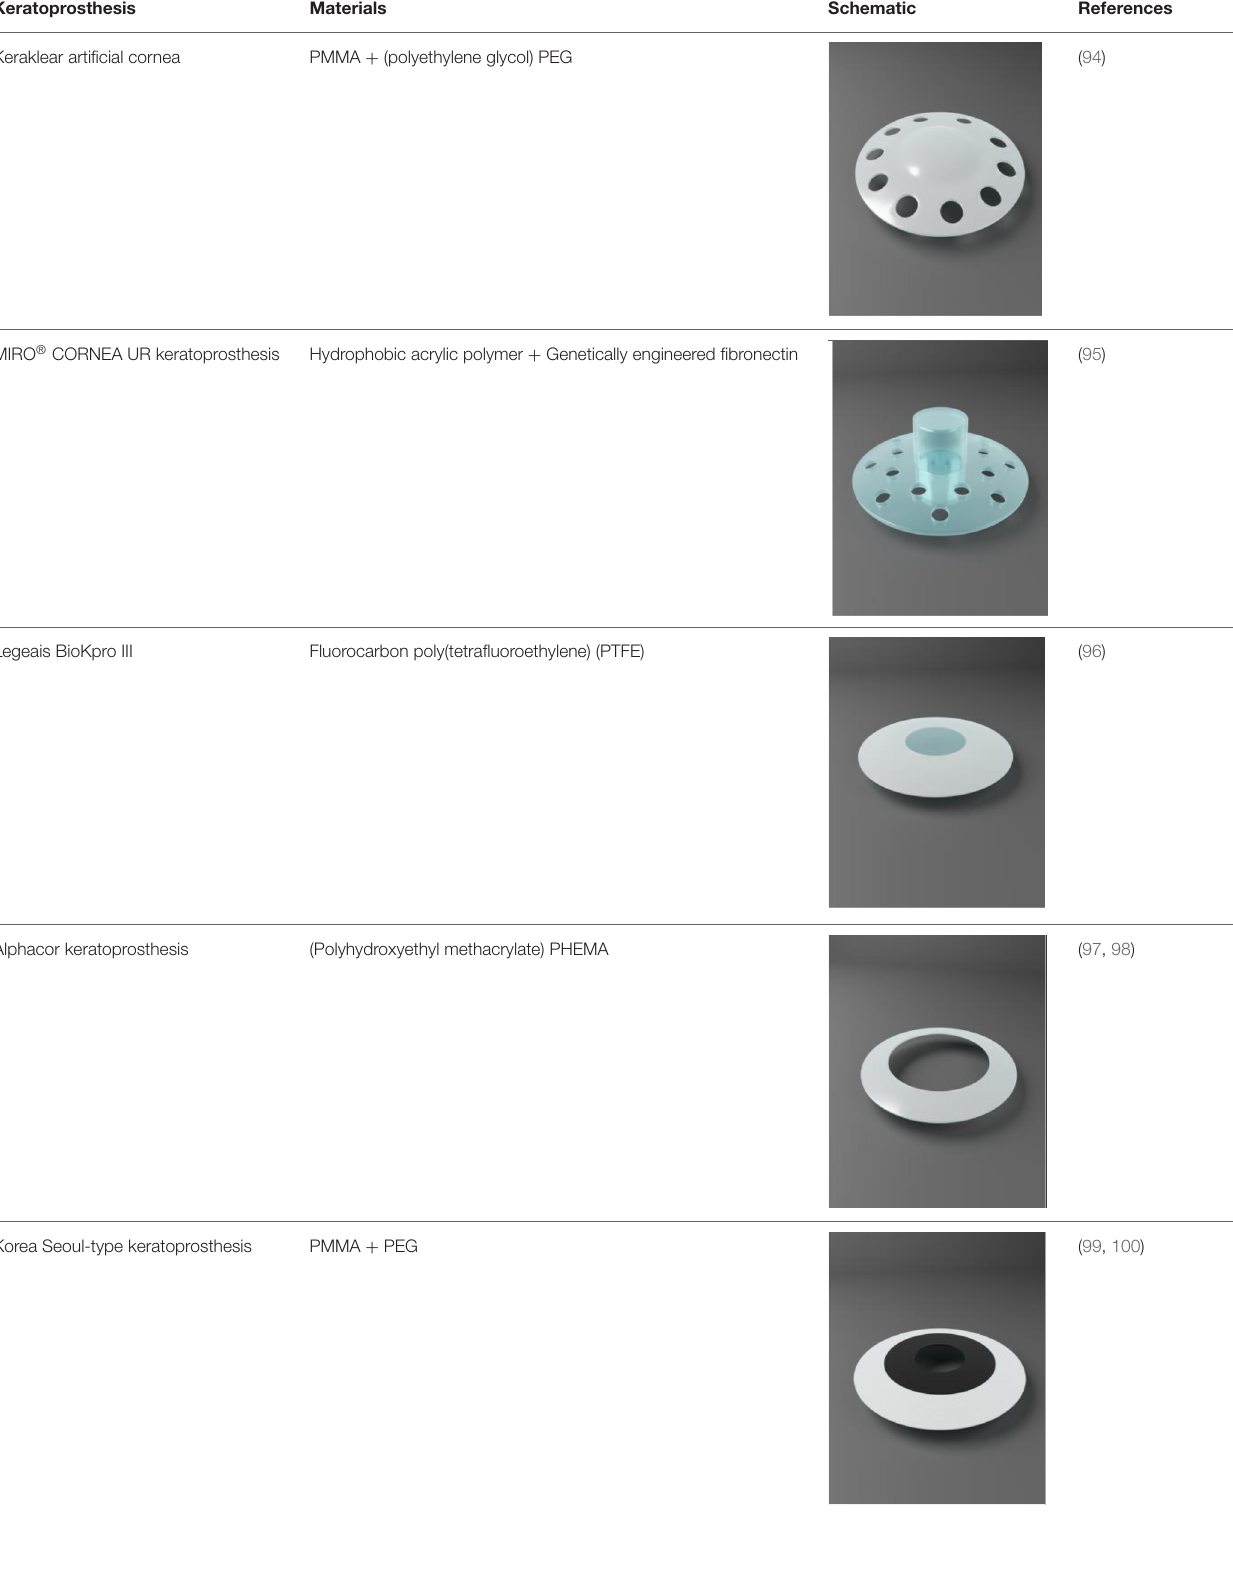
TABLE 3 | Description of commercial Soft-Keratoprostheses with skirts based on soft materials.